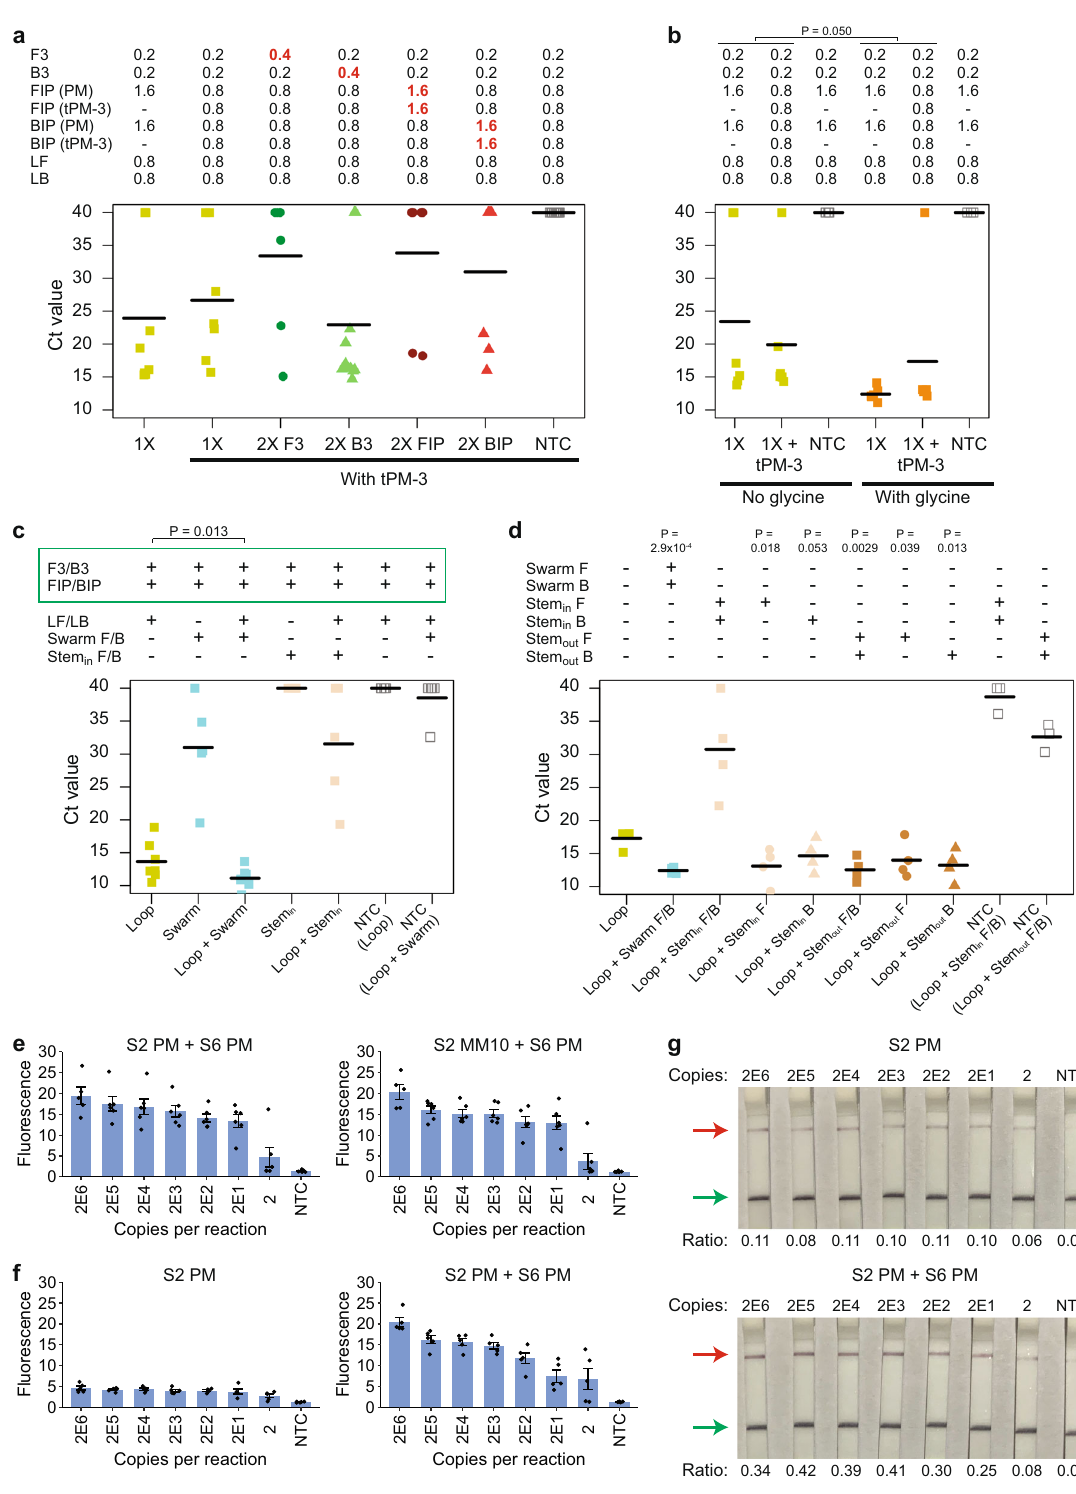
(Fig. 4f and Supplementary Fig. 21). In contrast, targeting of the S254F mutant template with both the S2 and S6 gRNAs yielded much higher fl uorescence signals. We further con fi rmed these results with a lateral fl ow assay, where a positive test outcome was clearly obtained with two gRNAs even when only 20 copies of the mutant template were present (Fig. 4g). Collectively, the data indicate that our assay is robust against variant nucleotides in the viral target and can detect low copies of